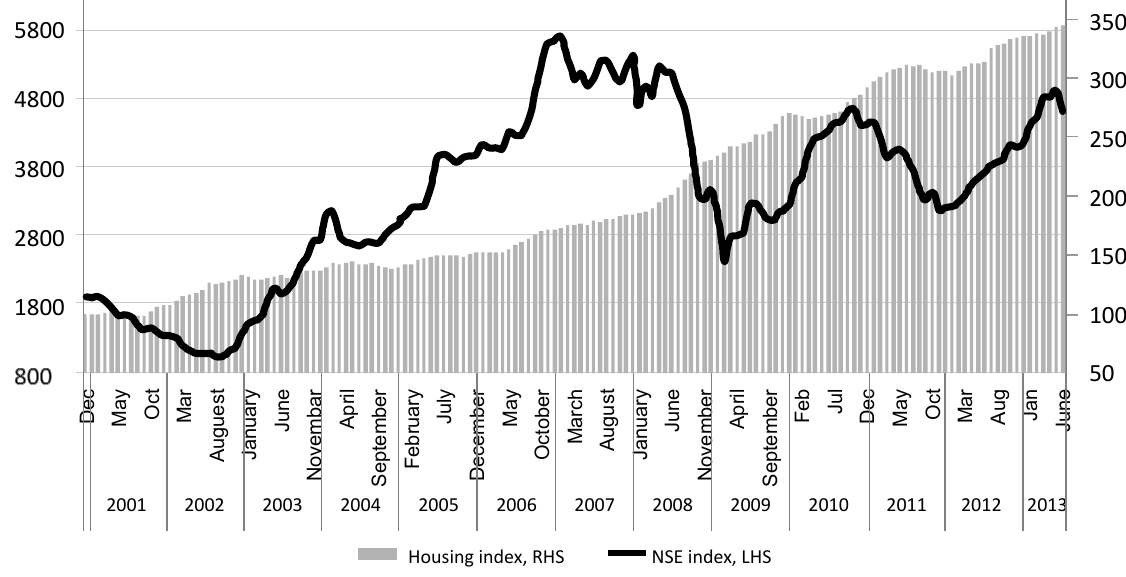
Figure 4. Development of Nairobi Stock Index and Housing